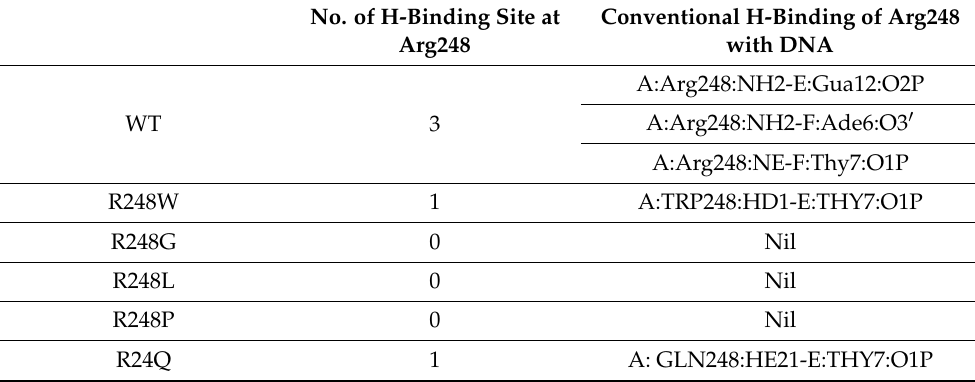
Table 4. Conventional H-bonds formed between the p53 protein amino acid Arg248 and DNA in different mutations. No. of H-Binding Site at Conventional H-Binding of Arg248 Arg248 with DNA